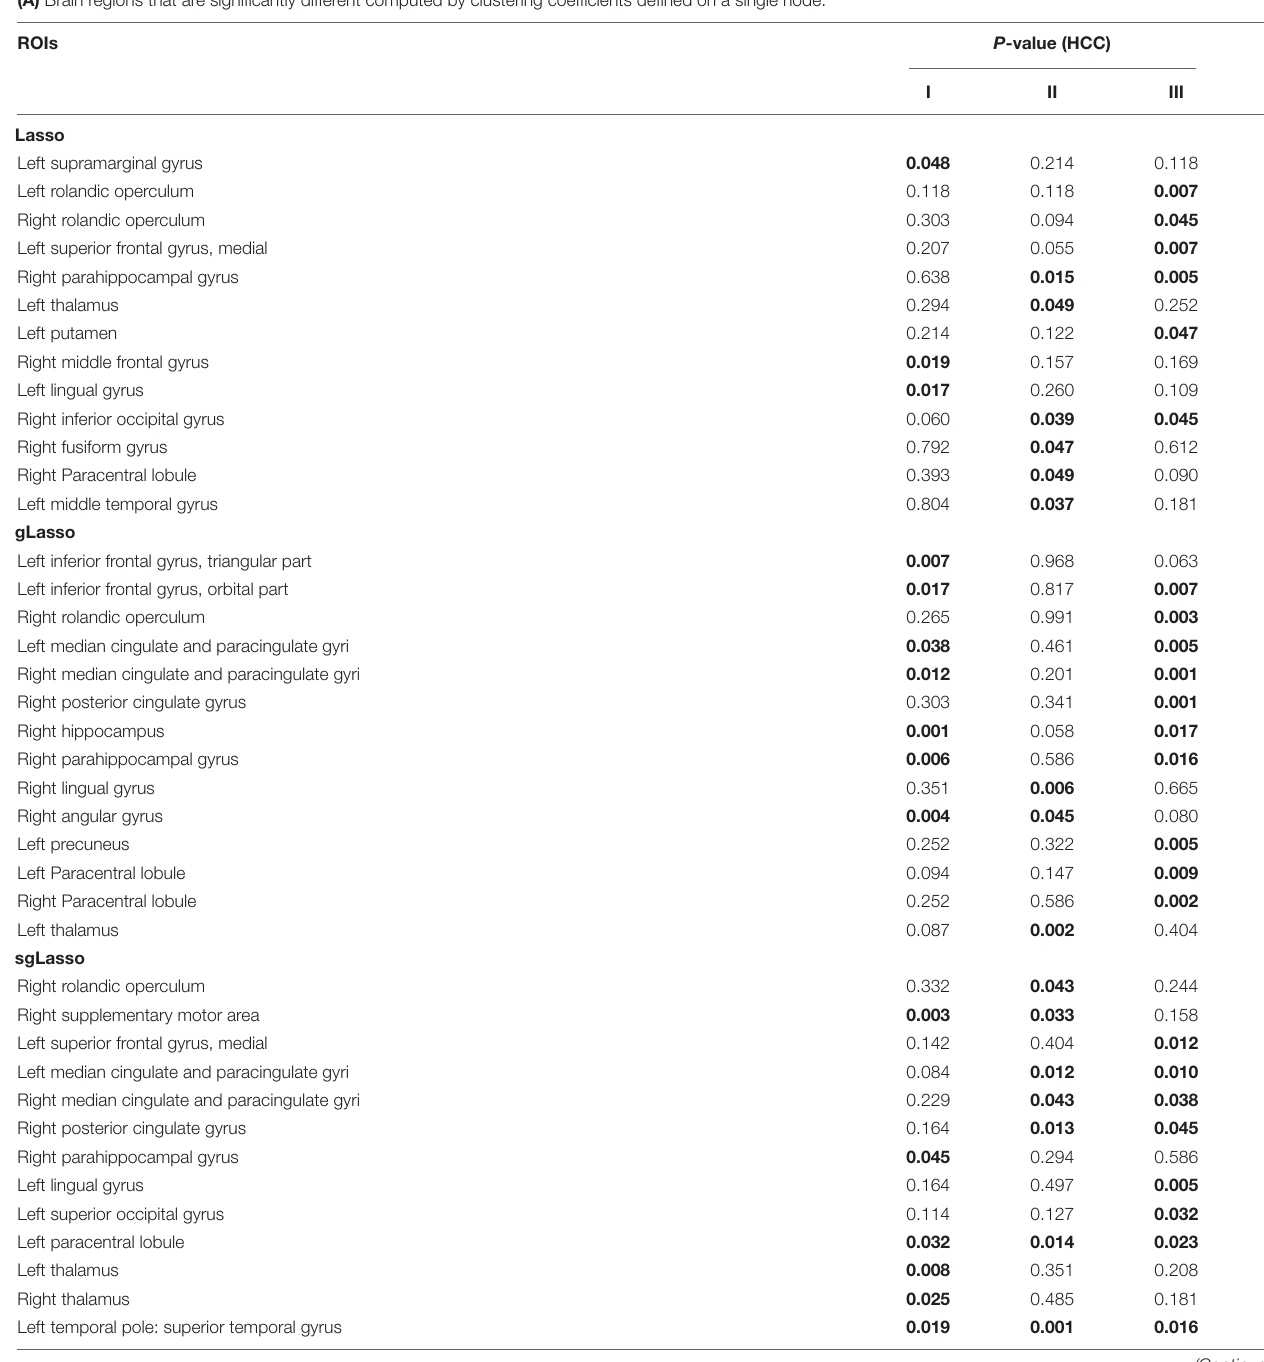
TABLE 3 | Brain regions that are significantly different computed by two different types of clustering coefficients. (A) Brain regions that are significantly different computed by clustering coefficients defined on a single